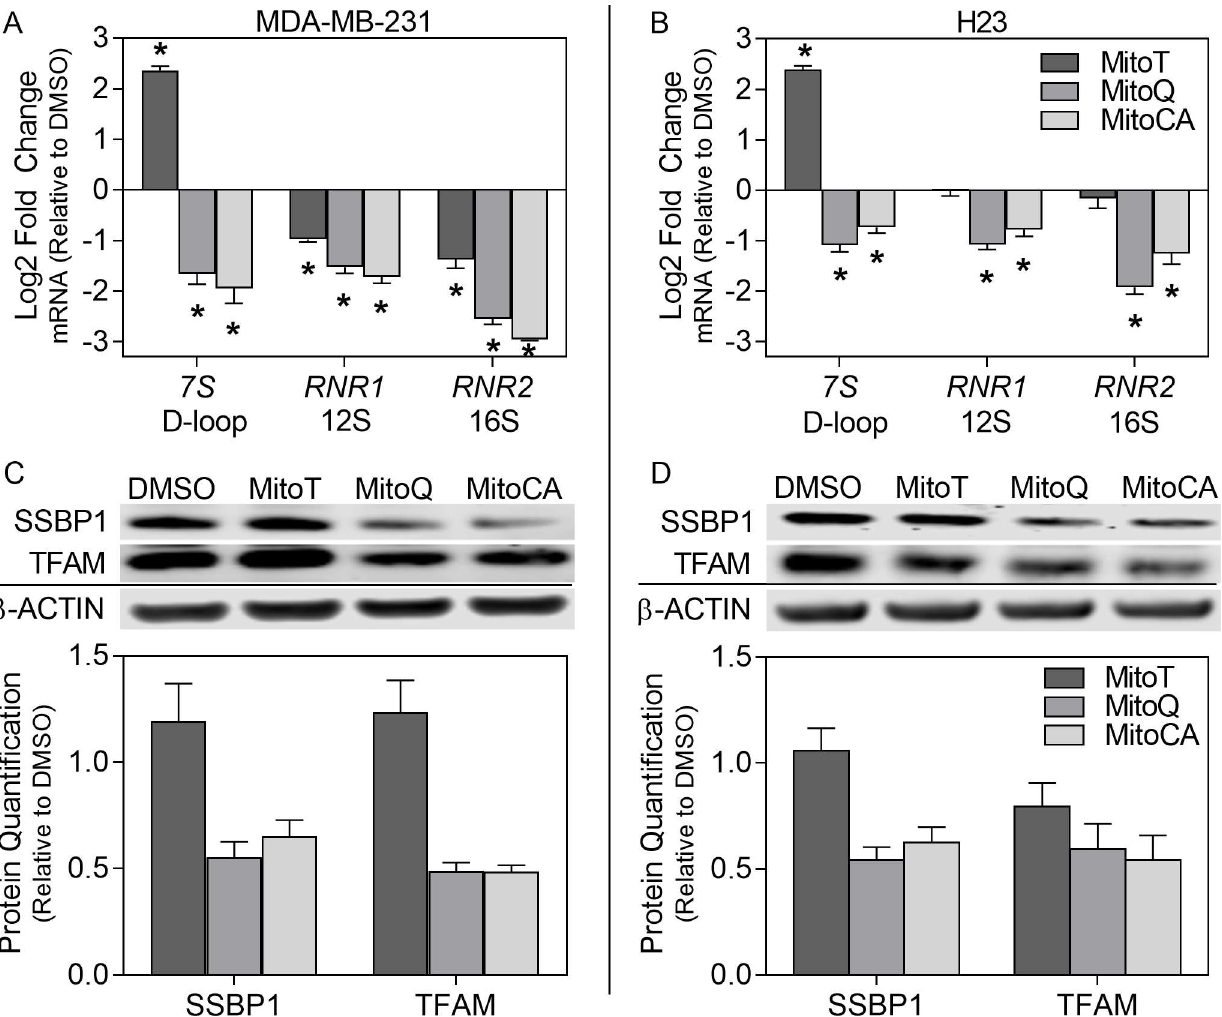
Fig 3. mtDNA gene expression and stability. Gene expressionof 7S , 12S ( RNR1 )and 16S ( RNR2 )transcripts (A-B) along with SSBP1 and TFAM protein levels (C-D) in MDA-MB-231 (A,C) and H23 (B,D) cell lines after 24 hours exposureto 0.02% DMSO or MitoT (dark gray bars), MitoQ (gray bars) or MitoCA (light gray bars) at 2 μ M. In A-B, bars represent the averagelog2 fold changenormalizedto GAPDH and the DMSO control. Statistical significanceis expressedas asterisks at p < 0.05relativeto the DMSO control. In C-D, bars signify the mean densitometry normalized to the corresponding DMSO treatment. For each endpoint, two independentexperiments were performed (n = 3). Error bars signify +/-1